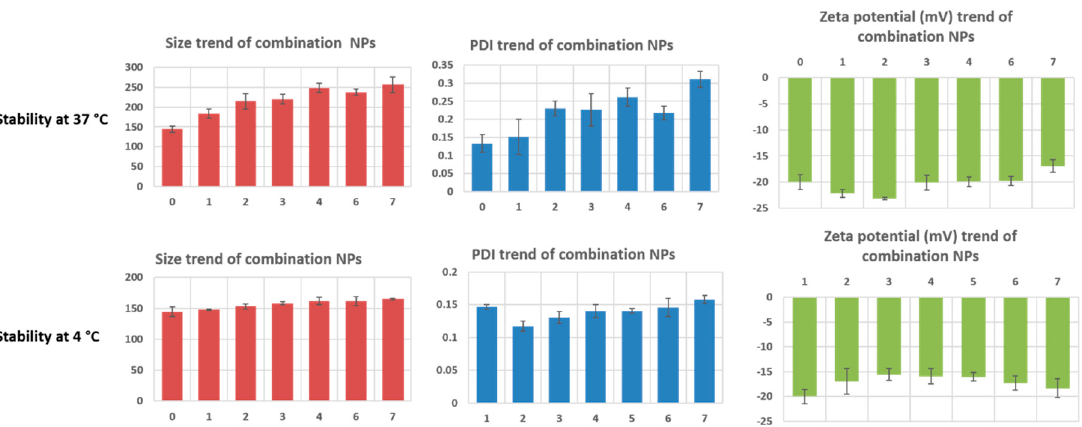
Figure 3. In vitro stability of combination NPs at 4 °C and at 37 °C in media containing 10% fetal bovine serum (FBS). PDI: polydispersity index.